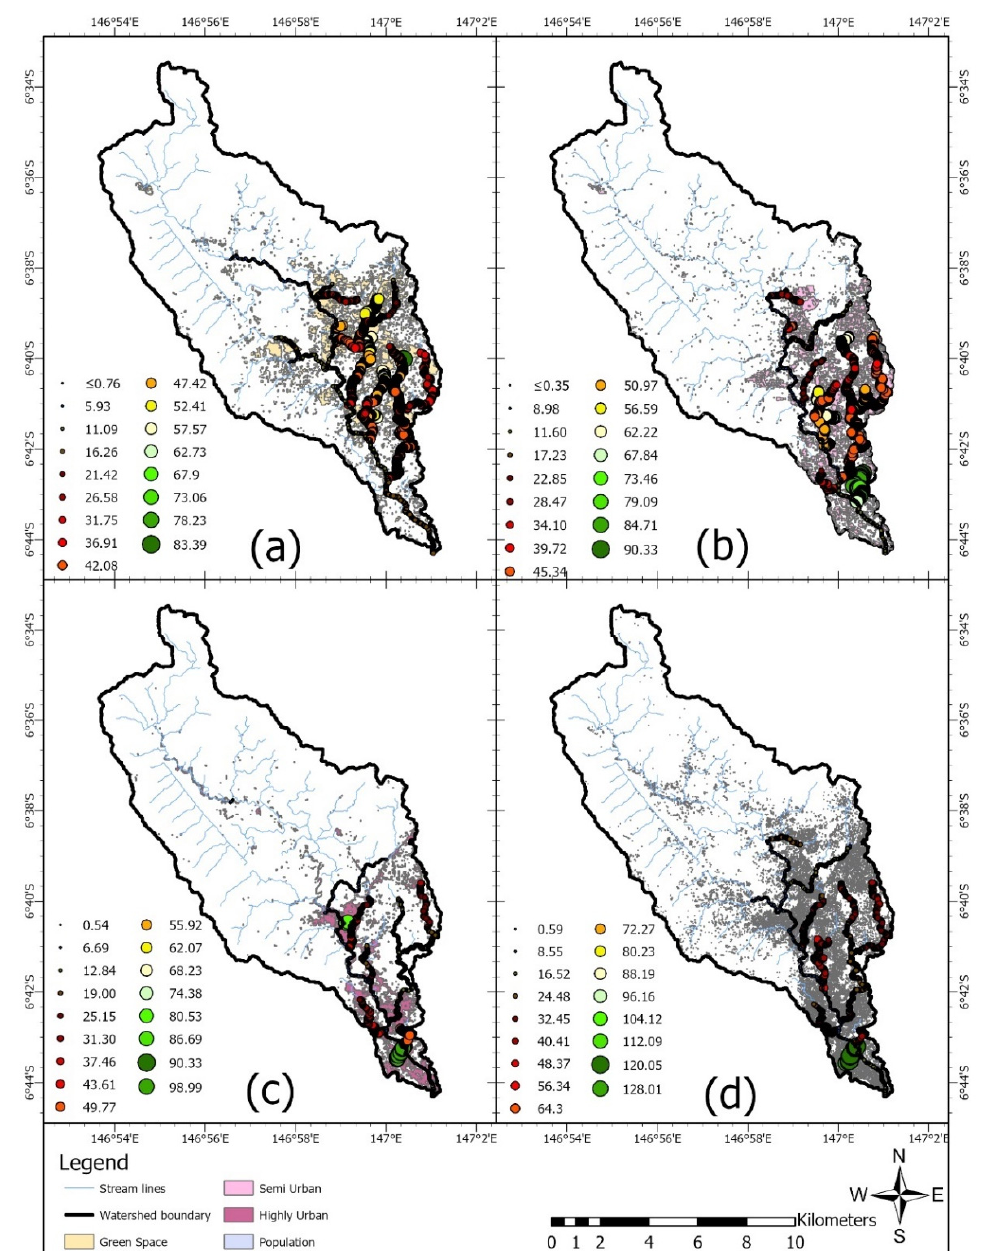
Figure 12. Distribution of RUNOFF importance values (IV) scaled 1 to 200 for ( a ) GREEN SPACE overlain on green space polygons, ( b ) SEMI-URBAN overlain on semi-urban polygons, ( c ) HIGHLY URBAN overlain on highly urban polygons and ( d ) POPULATION/HABITATION overlain on habitation/population layers.